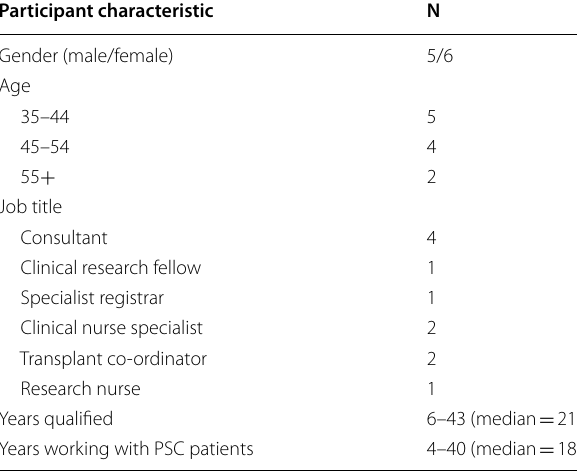
Table 9 Characteristics of clinician